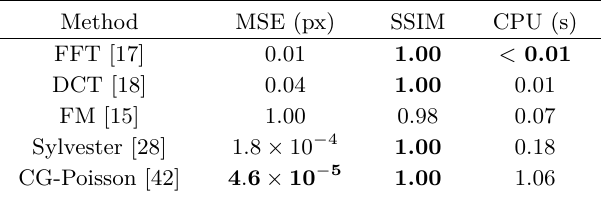
Results on the “Sombrero” dataset (256 × 256). As expected, all methods provide reasonably accurate solutions. However, the FM result is slightly less accurate: this is due to error accumulation by the local nature of FM, while the other methods are global . The reconstructed surfaces are shown in Fig. 3